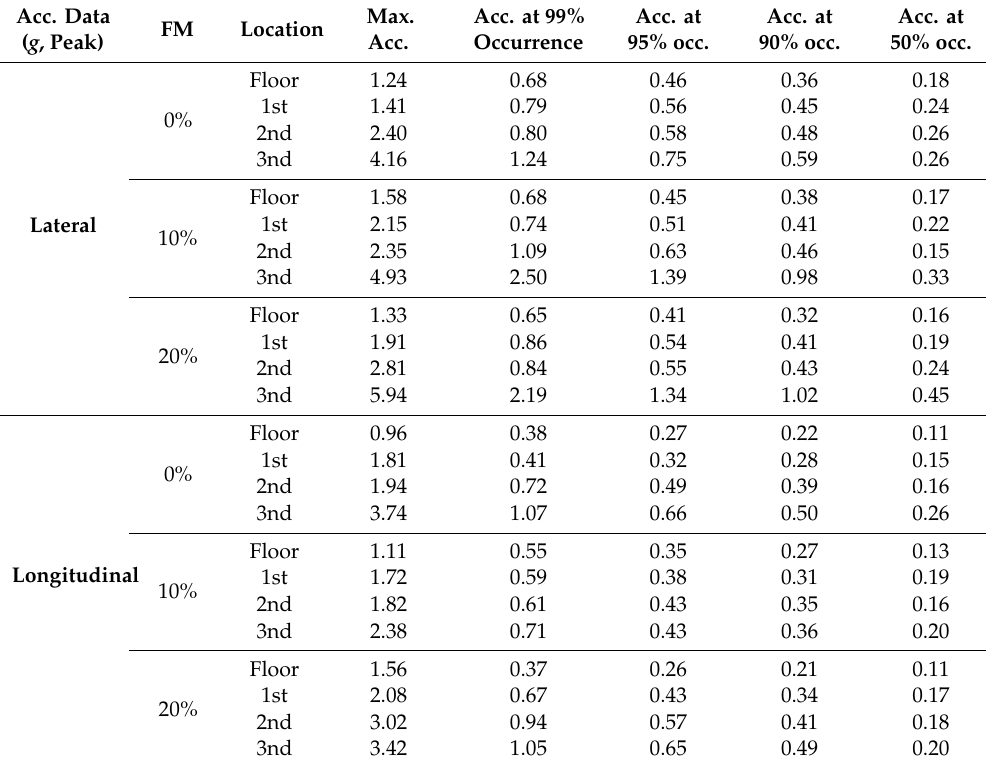
Table 3. Summary of measured acceleration (acc.)